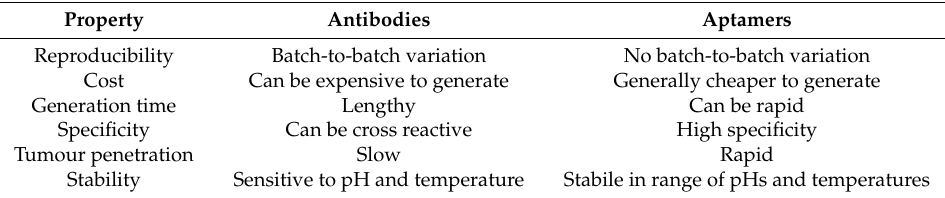
Table 2. Comparison of antibodies versus aptamers (adapted from